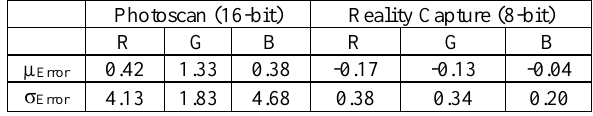
Table 6. 32-bit colour errors (measured in tones) of a colour chart measured as 16-bit images before and after processing the images in Agisoft Photoscan (2018) and Capturing